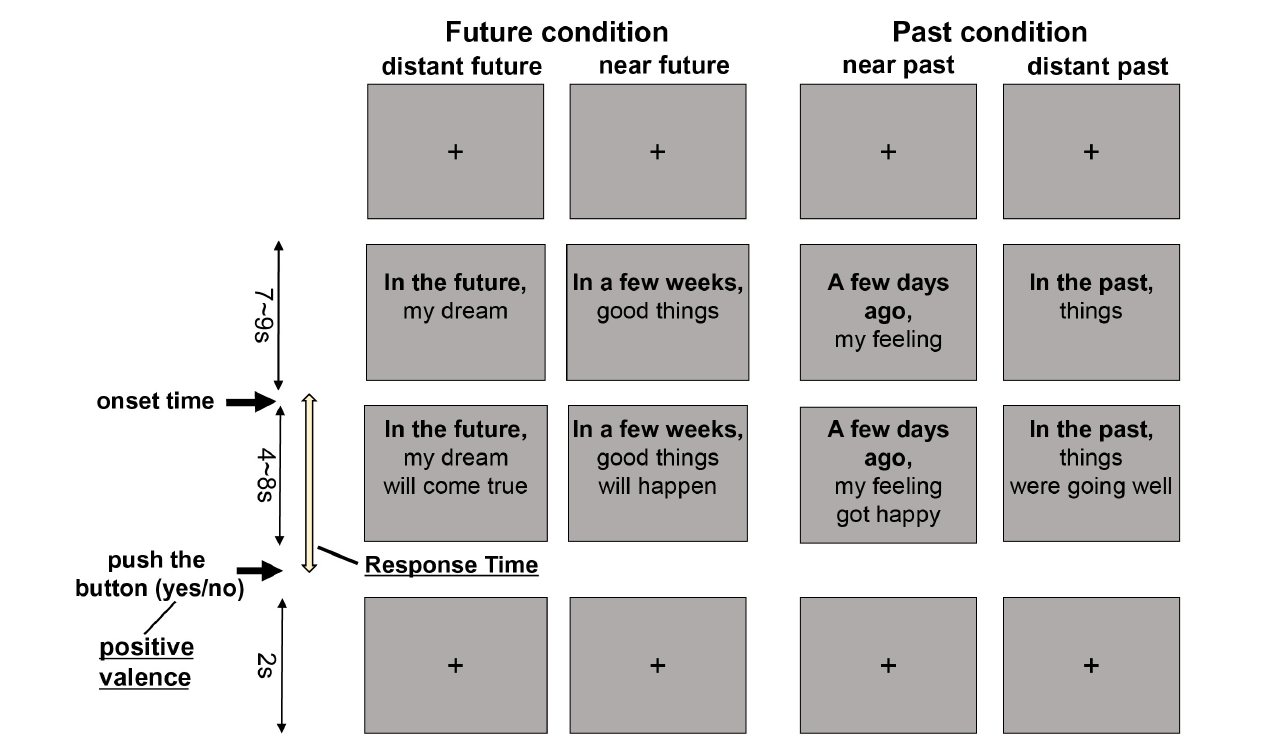
FIGURE1 Future thinking task. Example trials for four different conditions are shown. Participants were asked to imagine the future or recall the past when presented with a temporal word on a slide. Once the sentence was complete, participants pushed a button to indicate a response of yes or